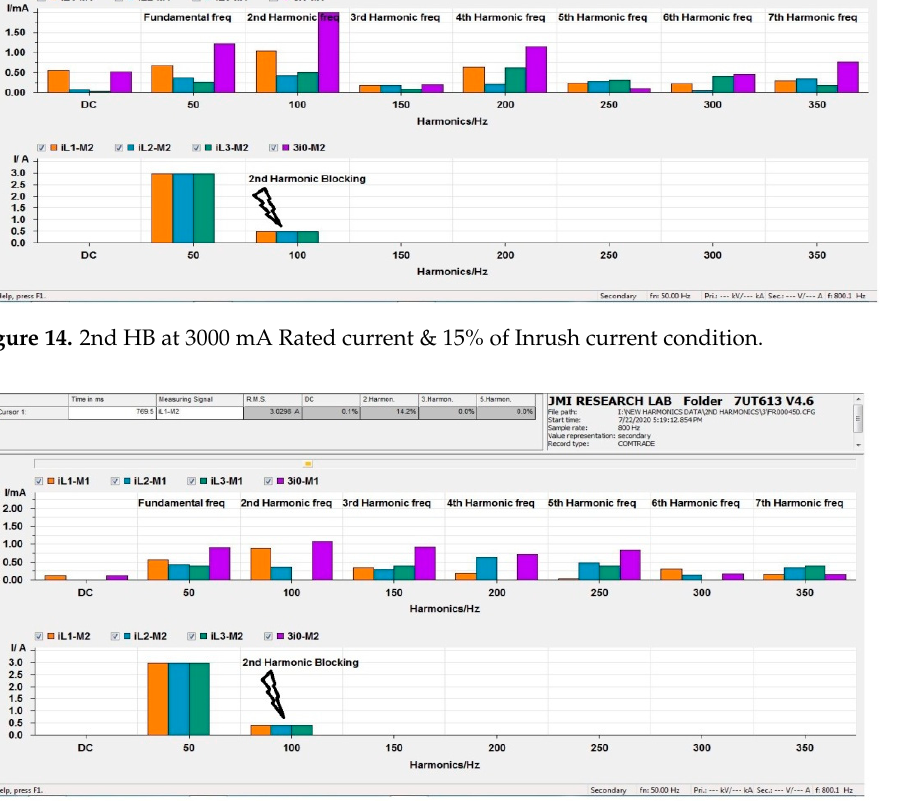
Figure 15. 2nd HB at 3000 mA Rated current & 18% of Inrush current condition.